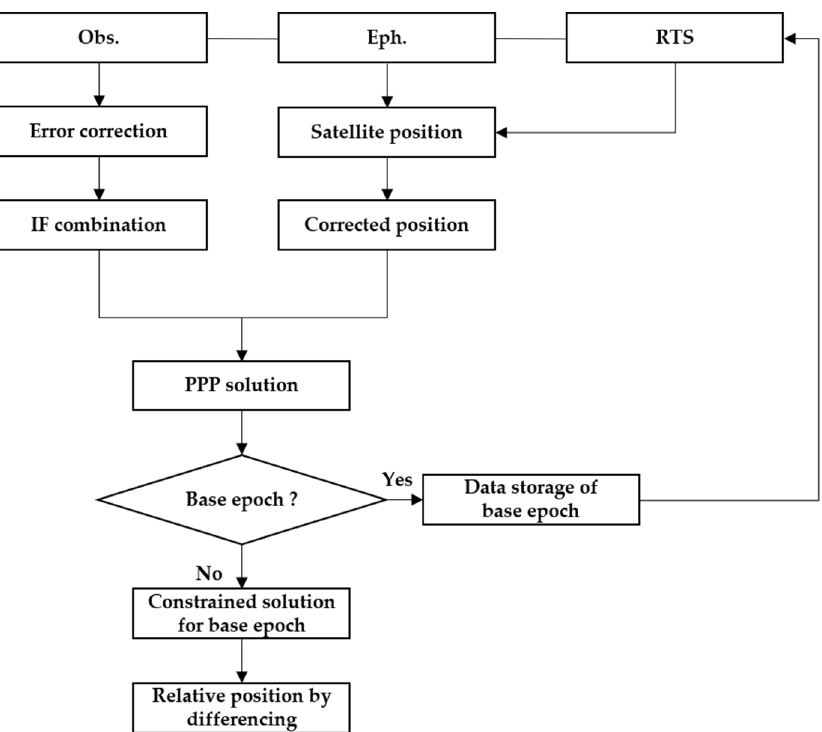
Figure 1. Flowchart of the proposed new algorithm.